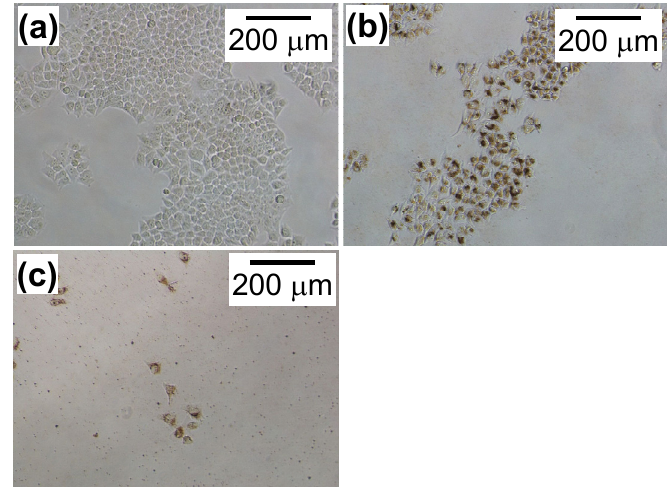
Figure 4. Images of HeLa cells with ( b ) PEI-coated MNPs added at 300 μ g/mL or ( c ) MNP/antibody complexes added at 300 μ g/mL. The image in ( a ) is of the control cells in Figure 1. There were fewer cells after adding PEI-coated MNPs and complexes compared to without these